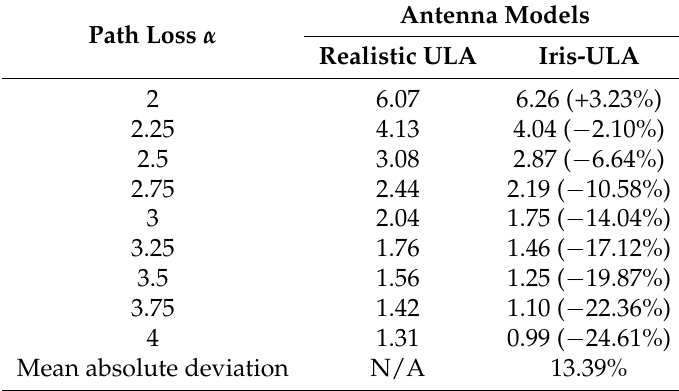
Table 3. E [( G r G t ) 2 α ] of the ULA antenna and iris-ULA antenna with deviations compared with the ULA antenna.